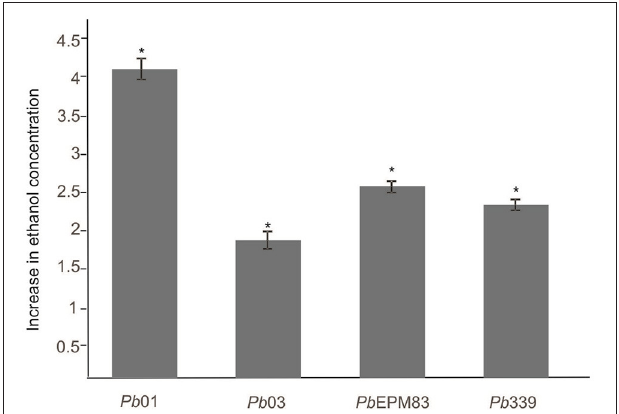
FIGURE 3 | Ethanol measurement in P. lutzii and P. brasiliensis . The concentration of ethanol (g/L) was determined in yeast cells of the isolates Pb 01, Pb 03, Pb 339, and Pb EPM83 upon growth in minimal media with sodium acetate (100mM) and glucose (100mM) for 48h. A total of 10 6 cells was used for each sample, and the ethanol compound was quantified using an enzymatic detection kit (UV-test for ethanol, RBiopharm, Darmstadt, Germany). Data are expressed as the mean ± standard deviation of biological triplicates in independent experiments. The data were analyzed by two-way ANOVA and Tukey’s multiple comparisons test. *Indicate significant differences among isolates at p -value of ≤